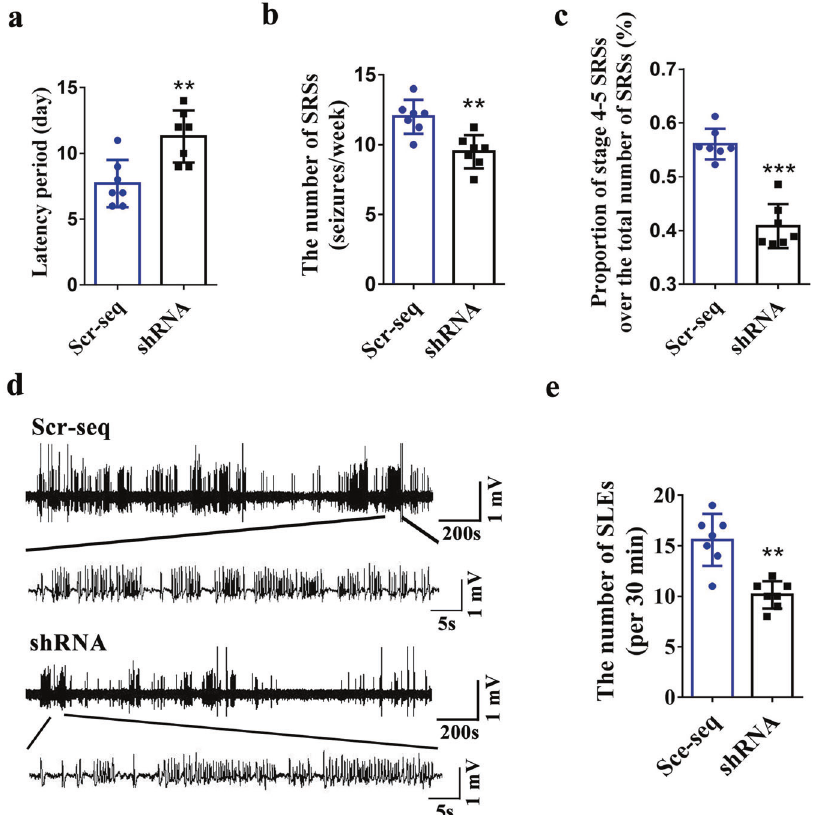
Fig. 3 The effect of vezatin knockdown on seizure activity in a mouse model of PILO-induced epilepsy. a Statistical analysis of the spontaneous recurrent seizures (SRSs) latency ( P = 0.004), b the number of SRSs (seizures/week) ( P = 0.002), and c the proportion of Racine stage 4 – 5 SRSs relative to the total number of SRSs (%) ( P < 0.001). d Representative images comparing hippocampal LFP recordings between the Scr-seq group and shRNA group and ( e ) the corresponding statistical analysis of the number of SLEs per 30 min, as identi fi ed from hippocampal LFP recordings ( n = 7 per group, P = 0.003). Student ’ s t test; * P < 0.05, ** P < 0.01, and *** P < 0.001.